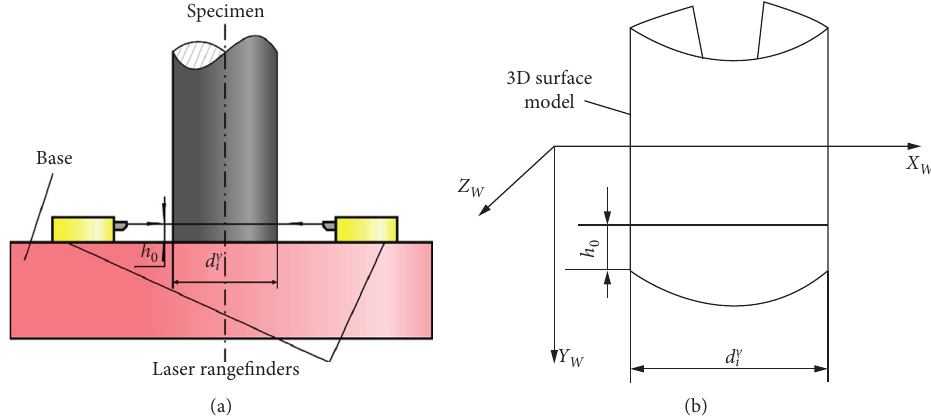
Figure 19: Schematic diagram of data acquisition: (a) acquisition of laser measurements; (b) acquisition of vision